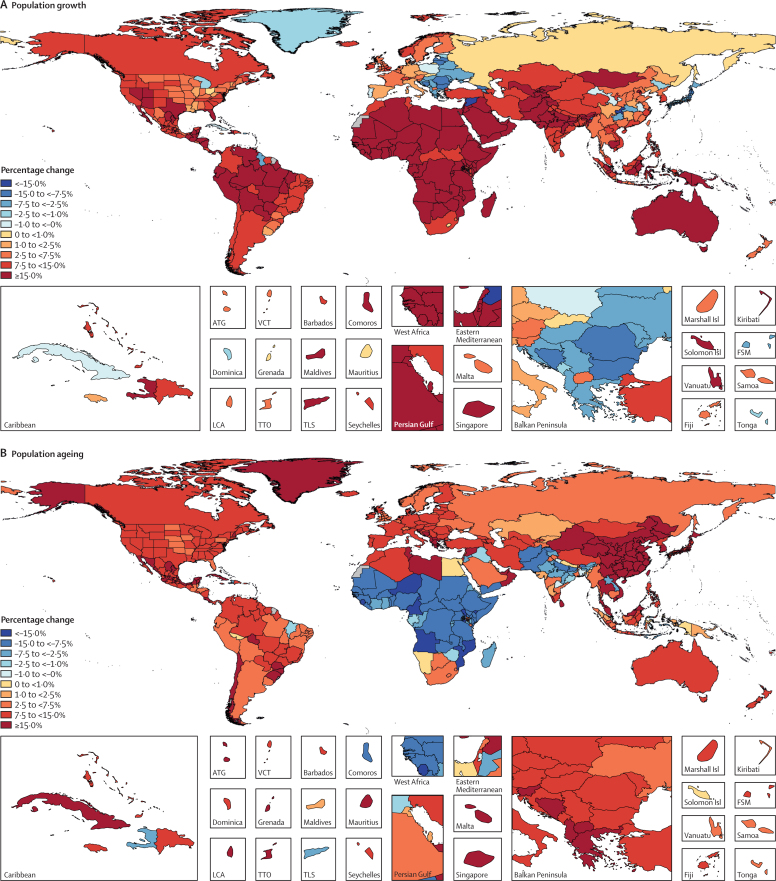
Percentage change in the absolute number of all-cause risk-attributable DALYs for both sexes, by location, 2007–17Changes due to population growth (A), population ageing (B), changes in risk-deleted DALY rates (C), changes in exposure to environmental and occupational risk factors (D), changes in exposure to behavioural risk factors (E), and changes in exposure to metabolic risk factors (F). The risk-deleted DALY rate is the expected DALY rate if the exposure level for all risk factors were reduced to the theoretical minimum risk exposure level. Changes in the risk-deleted rate might result from changes in risks and risk–outcome pairs not included in the Global Burden of Diseases, Injuries, and Risk Factors Study or changes in other factors such as treatment. ATG=Antigua and Barbuda. DALYs=disability-adjusted life-years. FSM=Federated States of Micronesia. Isl=Islands. LCA=Saint Lucia. TLS=Timor-Leste. TTO=Trinidad and Tobago. VCT=Saint Vincent and the Grenadines.